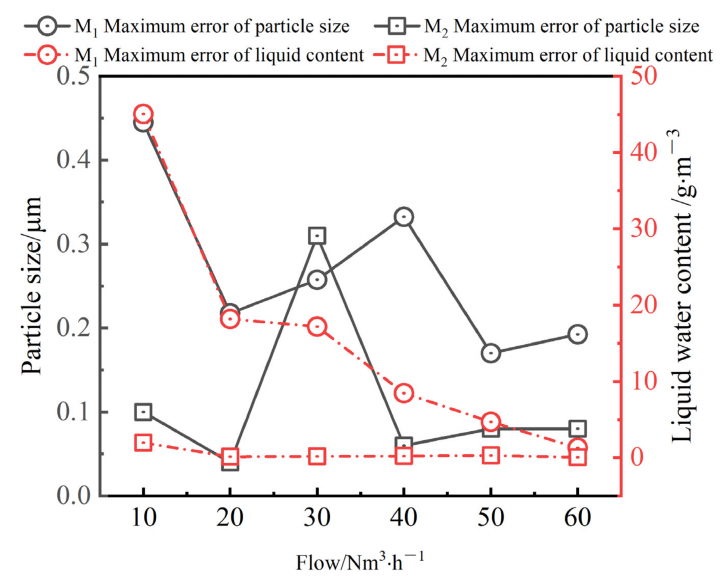
Figure 10. Error diagram for four